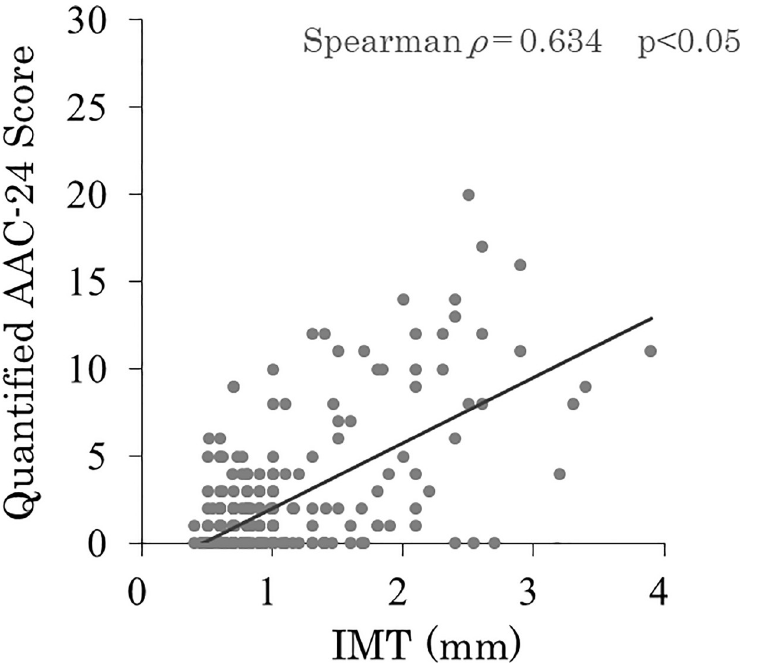
Fig 7. Relationship between AAC-24 scores and IMT (Spearman ρ = 0.634, p < 0.05).